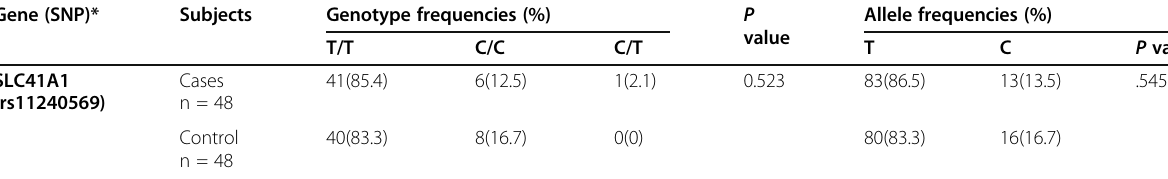
Table 5 Genotype distribution and allele frequencies in case and control groups Gene (SNP)* Subjects Genotype frequencies (%)